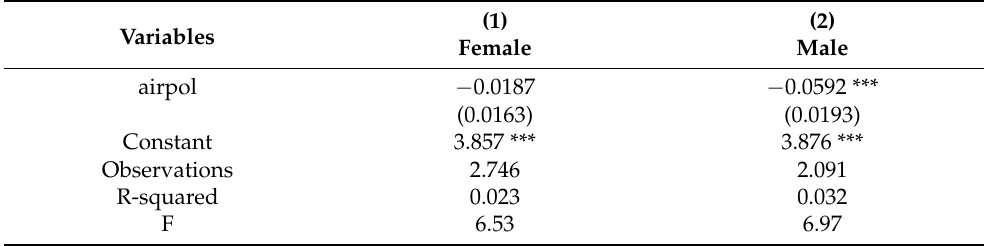
Table 7. Discussion on gender